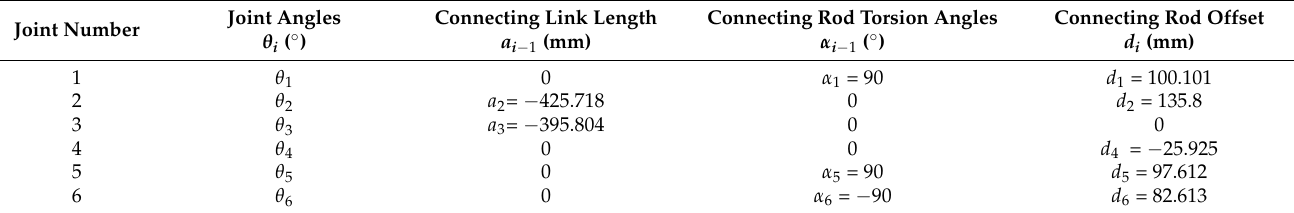
Table 1. DH parameters for the 6-DOF robotic